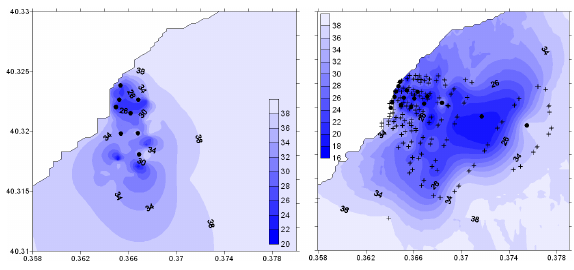
Fig. 8. Salinity contour plots for Badum surface coastal waters in October 2006 (left side) and June 2007 (right side).